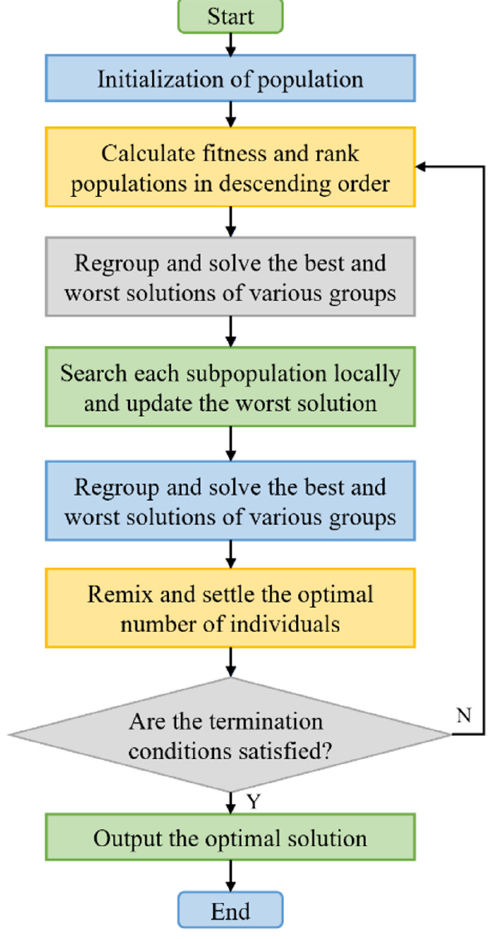
Figure 10. Flowchart of the shuffled frog leaping algorithm.